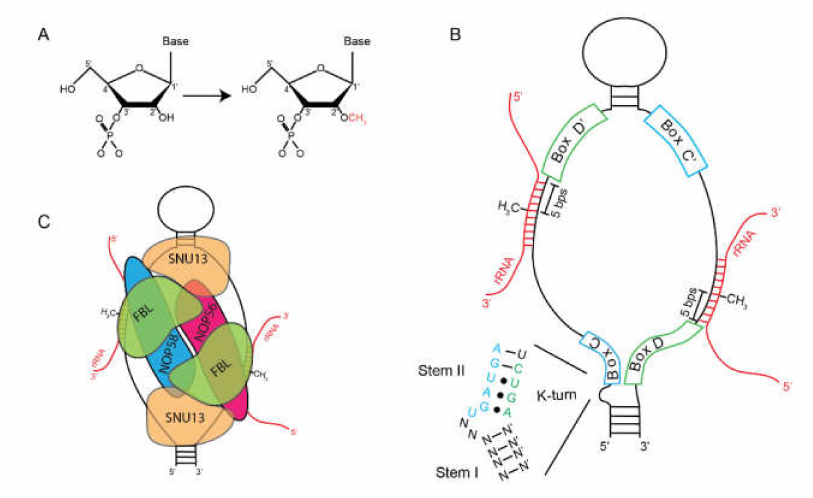
Figure 1. Box C / D snoRNPs. ( A ) Box C / D snoRNPs catalyze the methylation of the 2 (cid:48) hydroxyl of